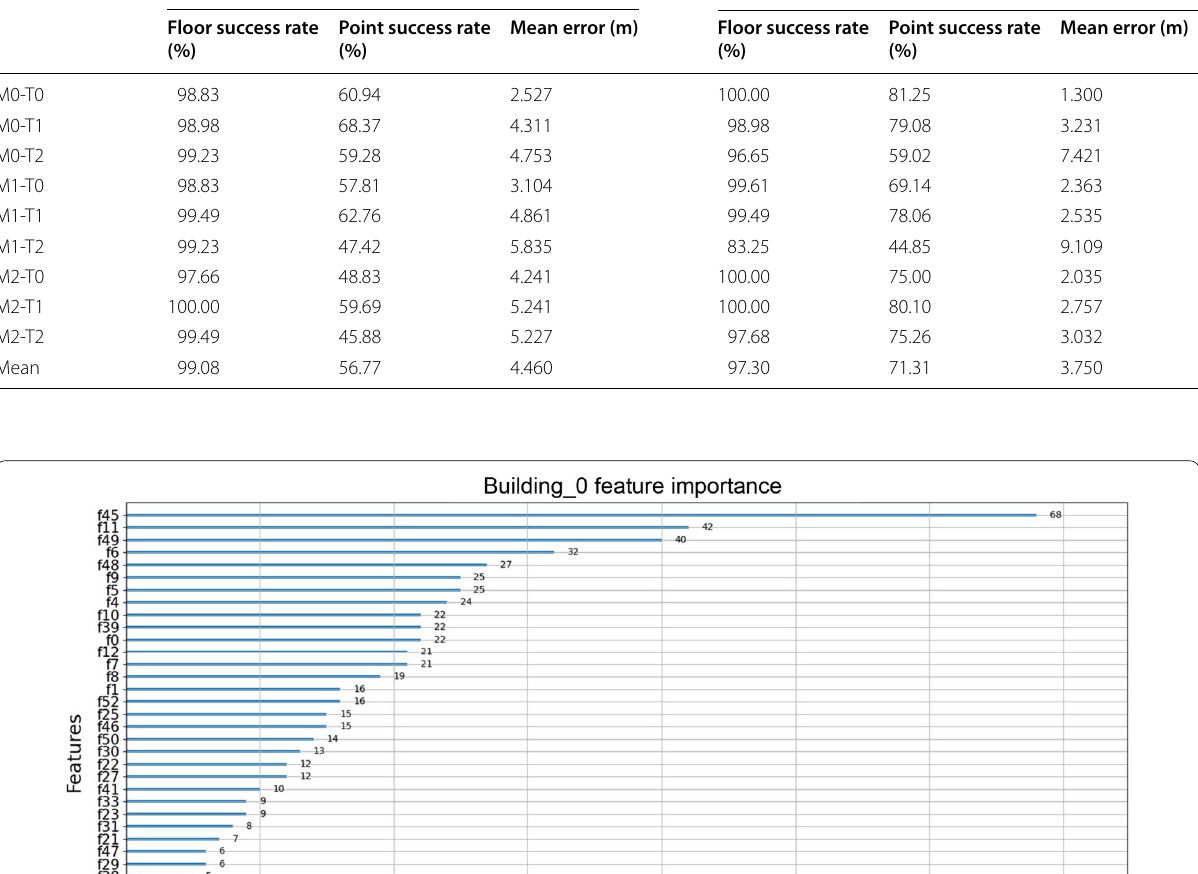
Table 9 The results of different testing samples using 23 features with XGBoost and GBDT Model-test